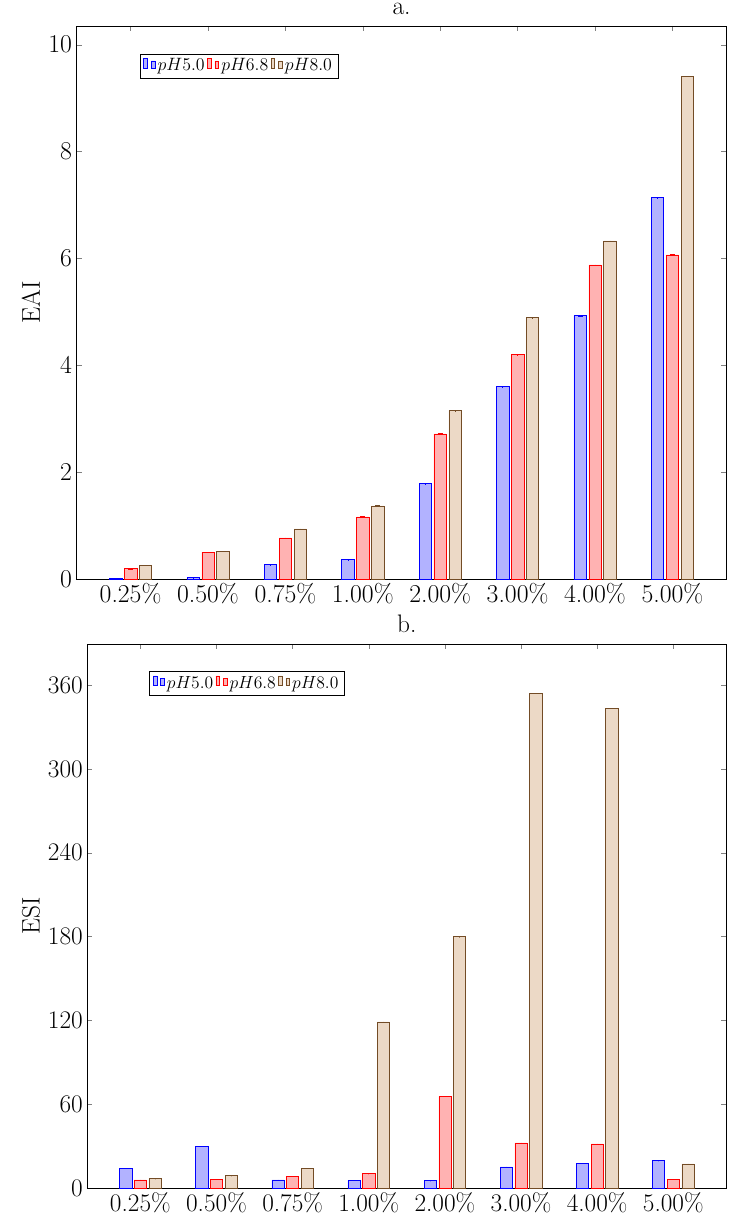
Figure 4. Emulsifying parameters of Vicia faba L. protein isolate solutions; ( a ) emulsion activity index (EAI), ( b ) emulsion stability index (ESI, min) as a function of isolate concentration and pH at 20 ◦